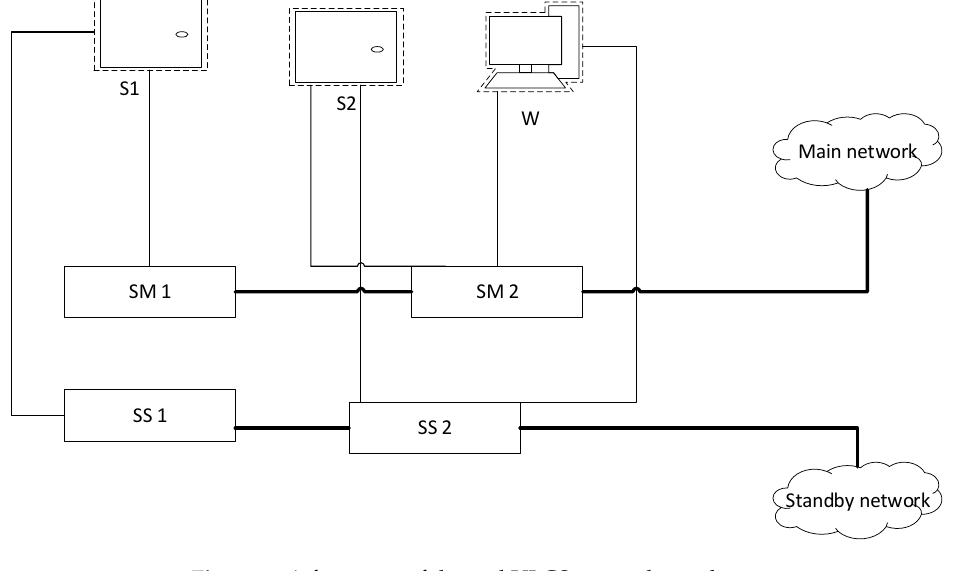
Figure 6. A fragment of the real ULCS network topology.